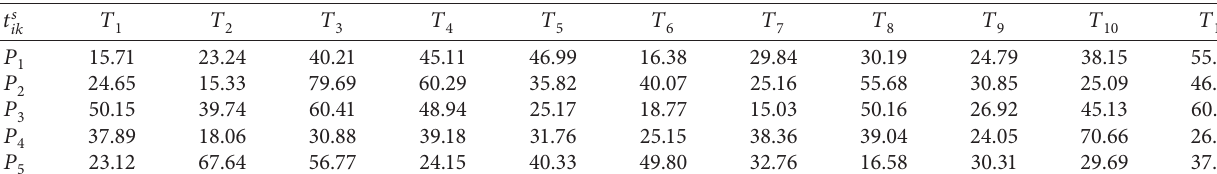
Table 8: The execution time for all tasks.